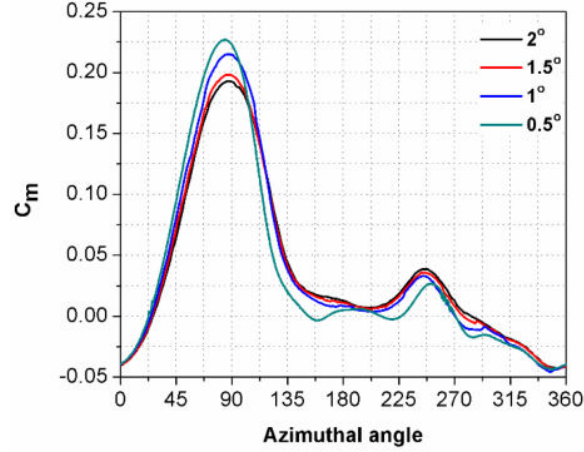
Figure 5. Variation of C m with azimuthal angle for various azimuthal